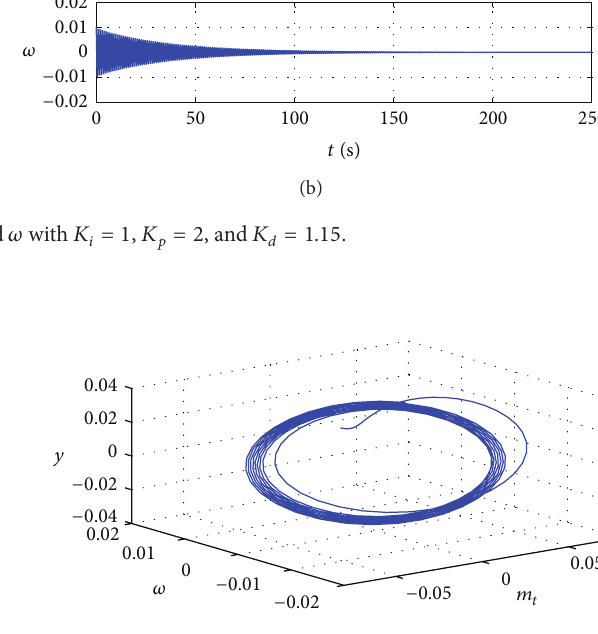
Figure 9: Phase orbit of 𝛿 , 𝜔 , and 𝑚 𝑡 . Figure 10: Phase orbit of 𝑚 𝑡 , 𝜔 , and 𝑦